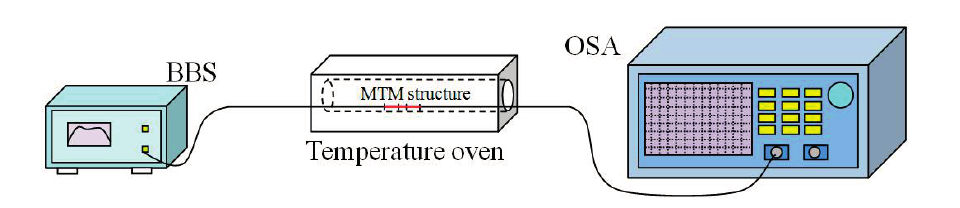
Figure 4. Schematic diagram of the experimental setup for SRI measurement.